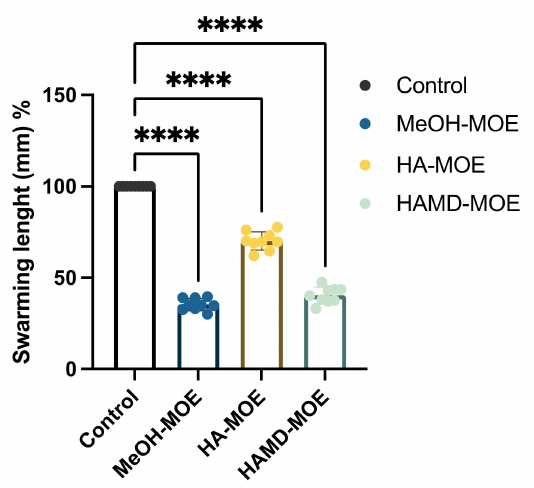
Figure 2. Effects of MOEs on swarming motility. EA movement is measured in mm; the measurement of the swarming area was taken from the point of inoculation and presented as the percentage compared to the control. Data are the mean of 3 independent experiments performed on triplicate (mean +/ − standard deviation), and values are represented as a percentage; **** p -values < 0.001.